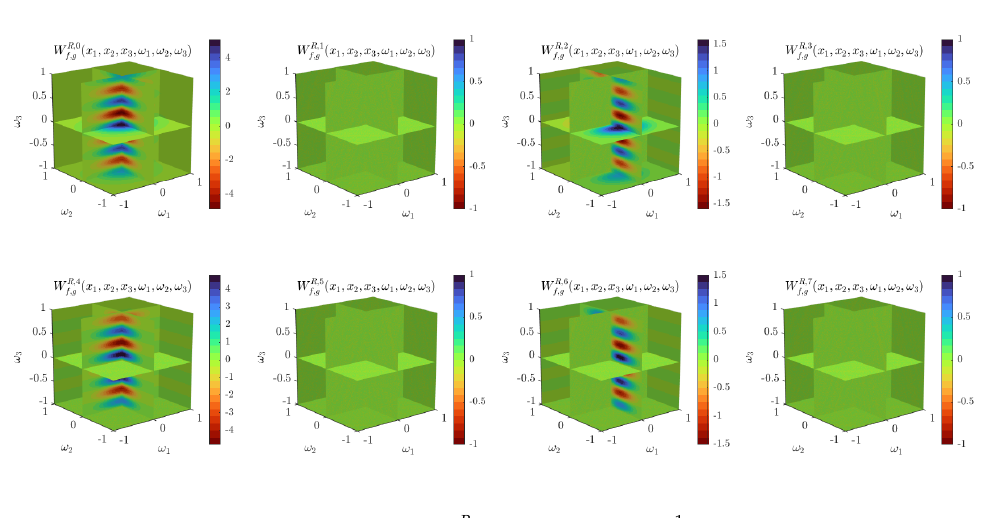
( x , · ) , where x = 1 f , g = ( 0.3,0.35,0.5 ) . 2